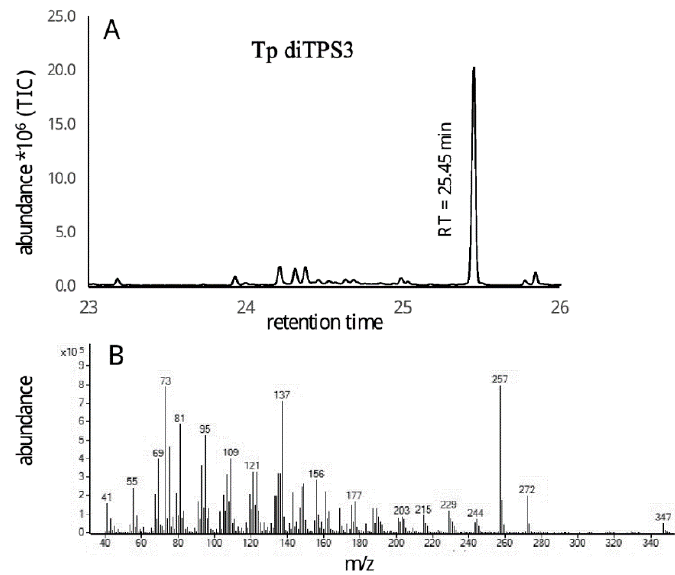
Figure 7. ( A ) = GC-MS analysis of copalol derived from geranylgeranyl diphosphate (GGDP) by TpdiTPS3, ( B ) = Mass spectrum of the chromatograph peak for TpdiTPS3.